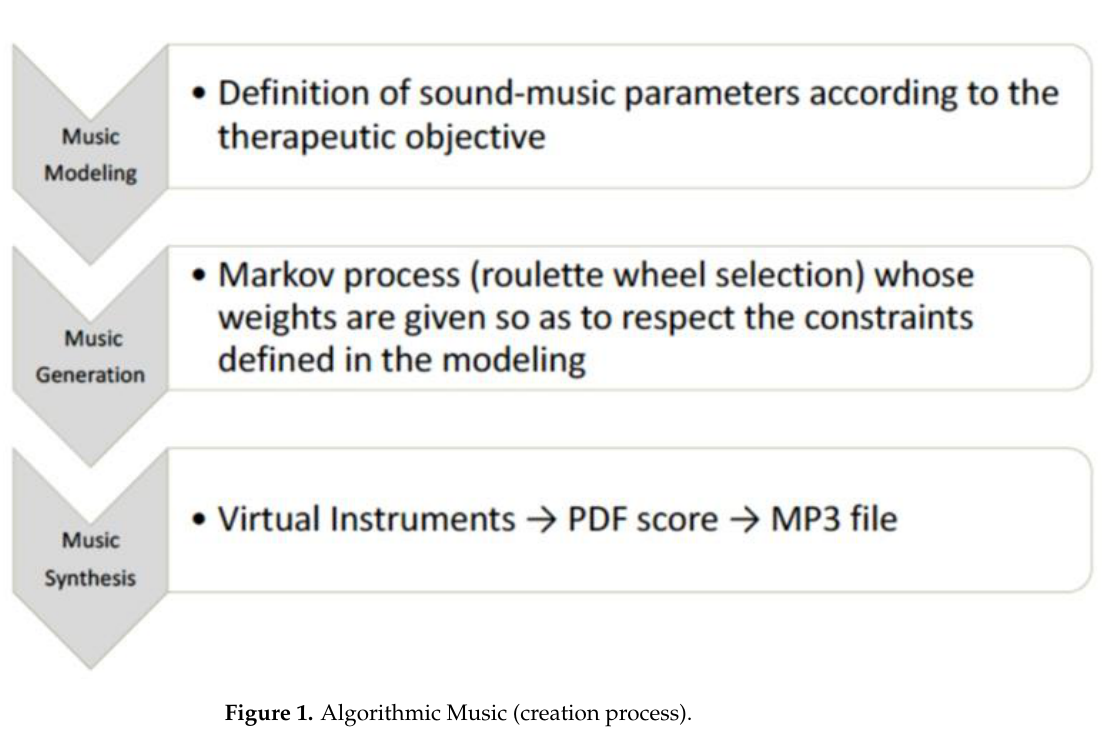
Figure 1. Algorithmic Music (creation process).